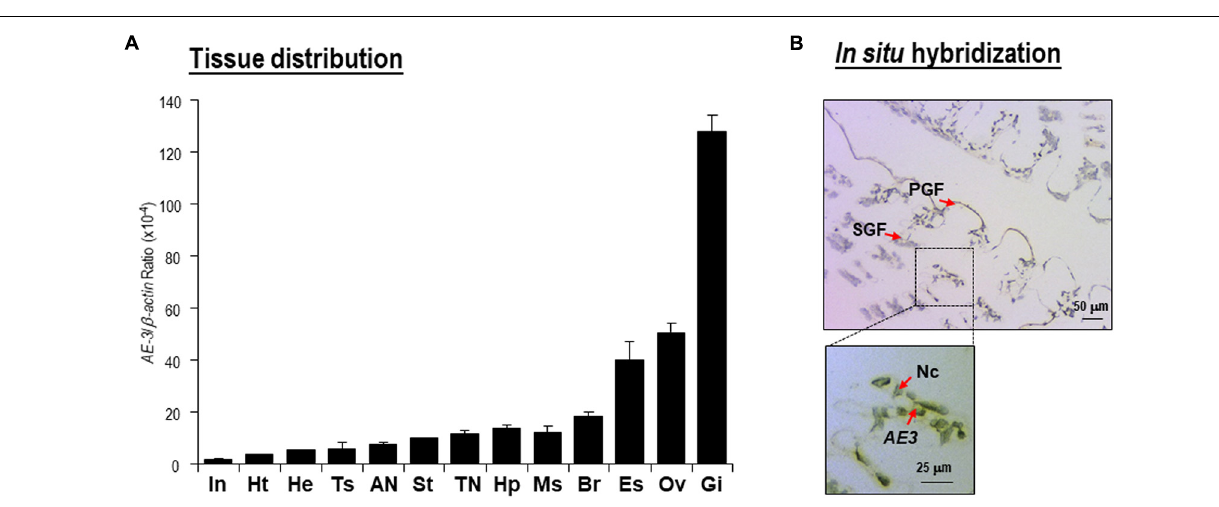
FIGURE 4 | (A) Tissue distribution of Lv-AE3 mRNA. The selected tissues included the eyestalk (Es), brain (Br), thoracic nerve (TN), abdominal nerve (AN), gill (Gi), heart (Ht), hepatopancreas (Hp), haemolymph (He), muscle (Ms), stomach (St), intestine (In), ovary (Ov), and testes (Ts). The data are presented as the means ± SE ( n = 5); (B) In situ hybridization of Lv-AE3 mRNA-expressing cells in the gill. PGF, primary gill filaments; SGF, secondary gill filaments; AE3 , Lv-AE3 mRNA (positive signal); Nc,